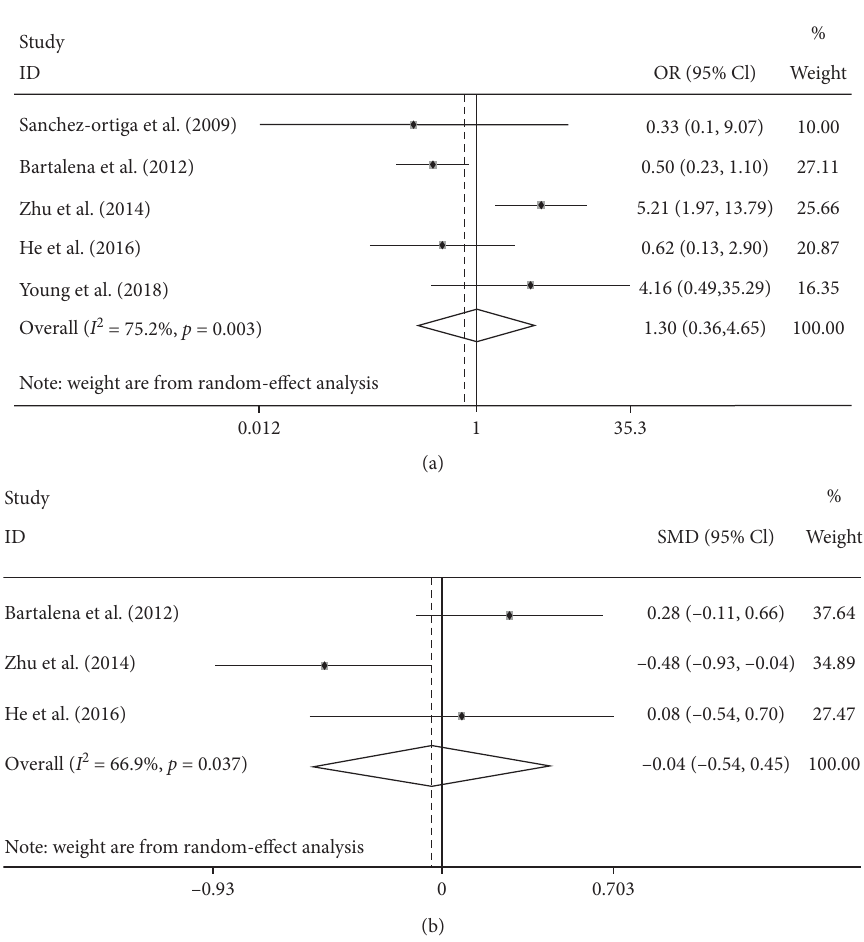
Figure 2: Forest plot of the response rate (a) and change of CAS (b), EUGOGO regimen vs. higher-dose